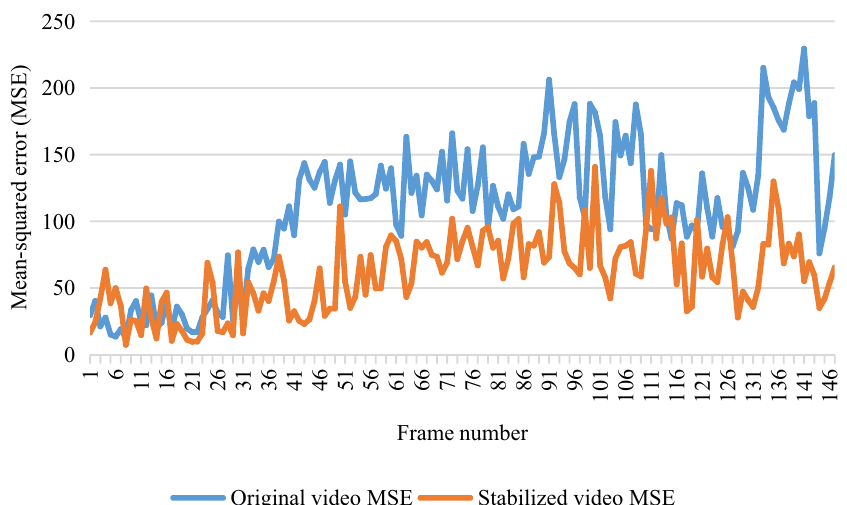
Figure 13. Mean squared error of the original video and the stabilized